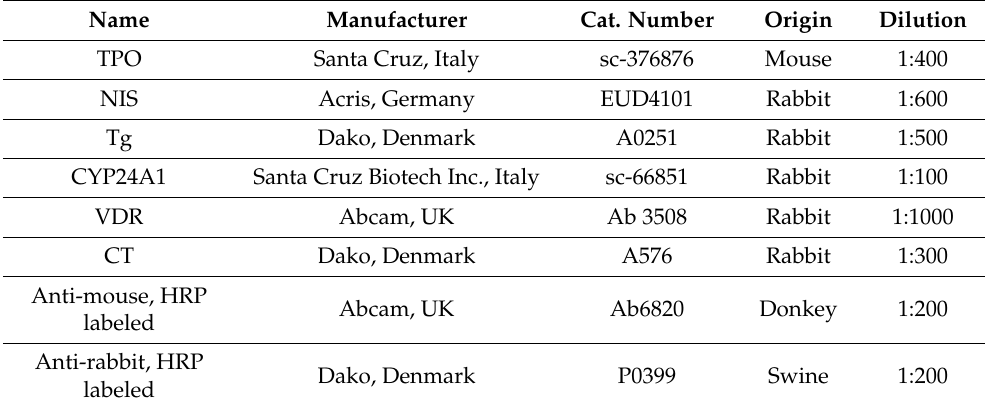
Table 1. List of primary and secondary antibodies used in IHC/IFC